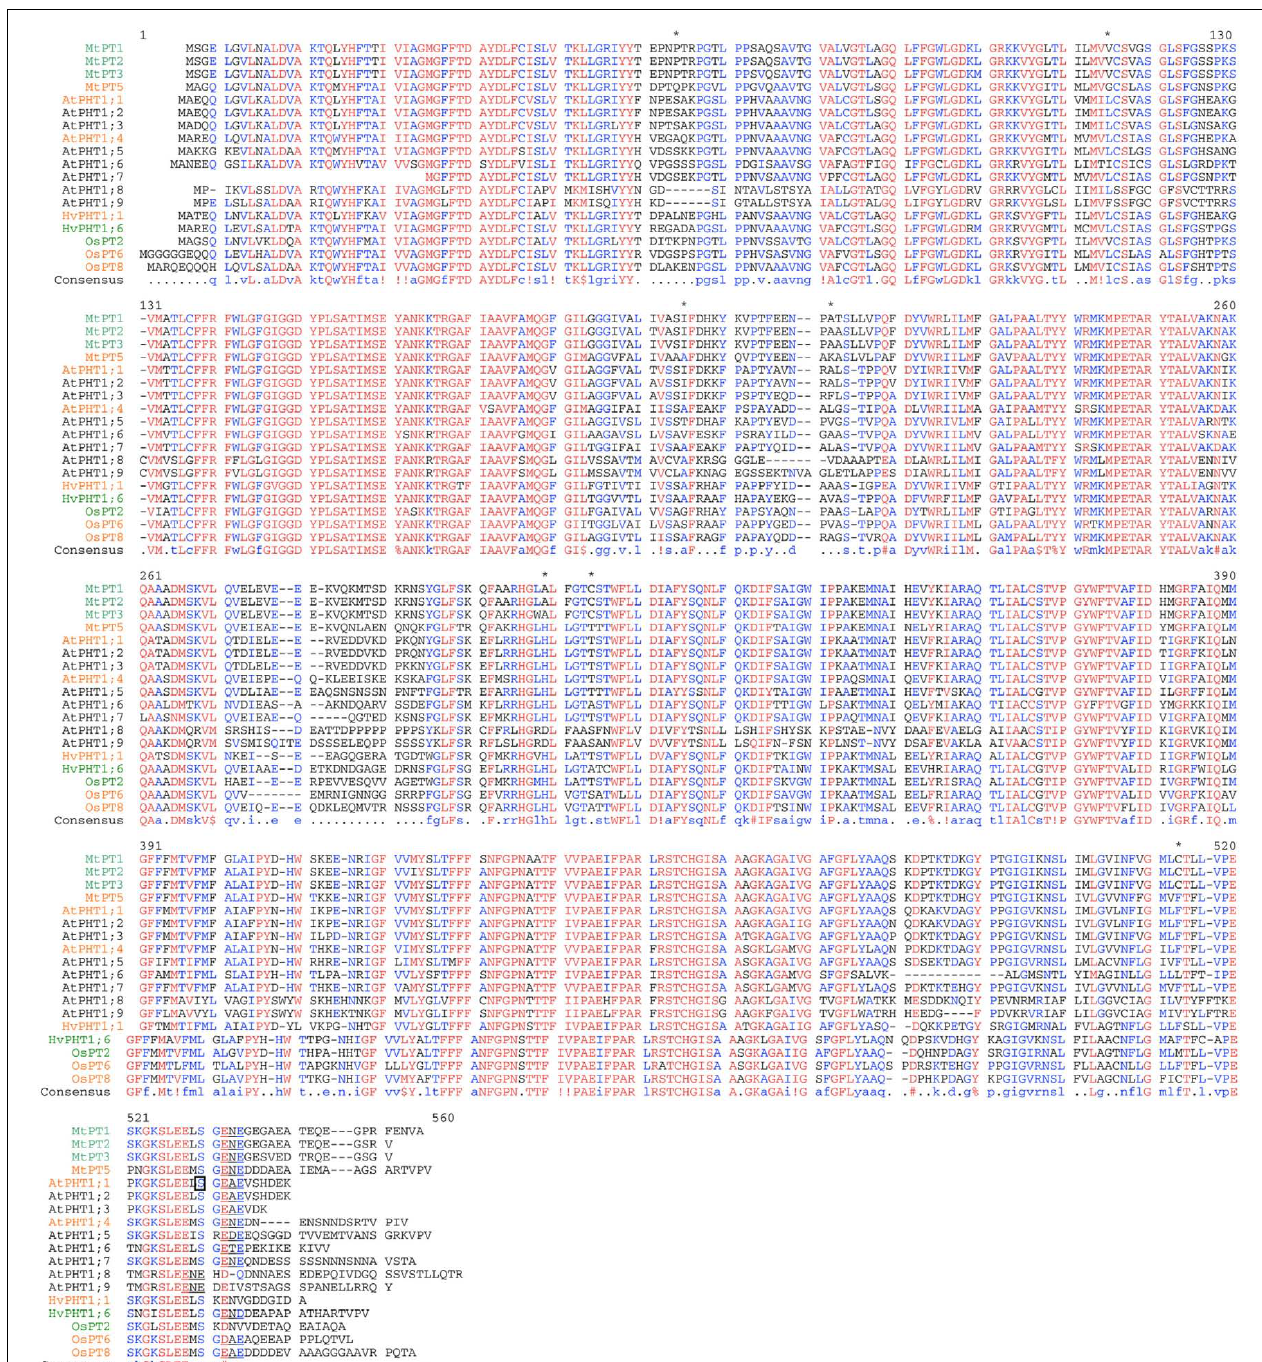
acids with non-conservative changes between the three low affinity (MtPT1, Mt PT2, MtPT3) and the high affinity transporters (MtPT5) identified by Liu et al. (2008).The serine identified in AtPHT1.1 (Bayle et al., 2011) that regulates exit from the ER is boxed and the putative ER exit site is underlined.